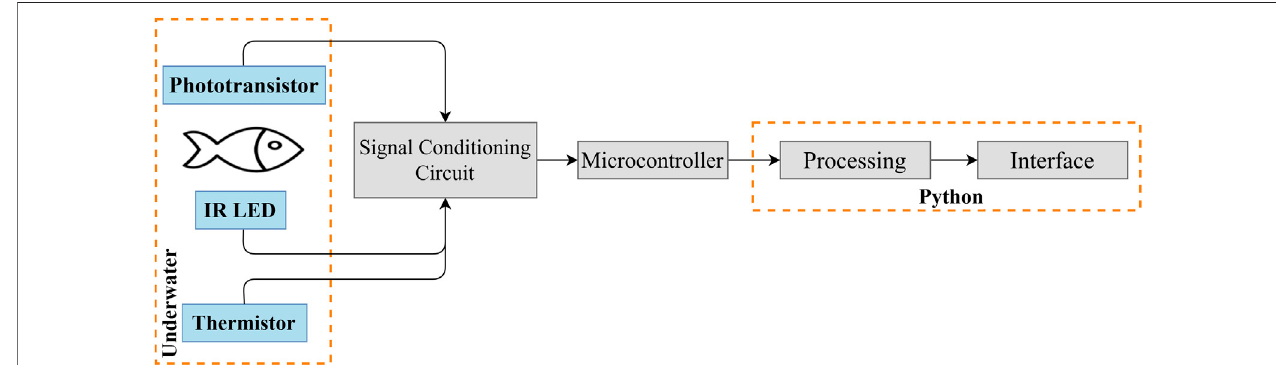
FIGURE 5 | Block diagram of the heartbeat and water temperature measurement and